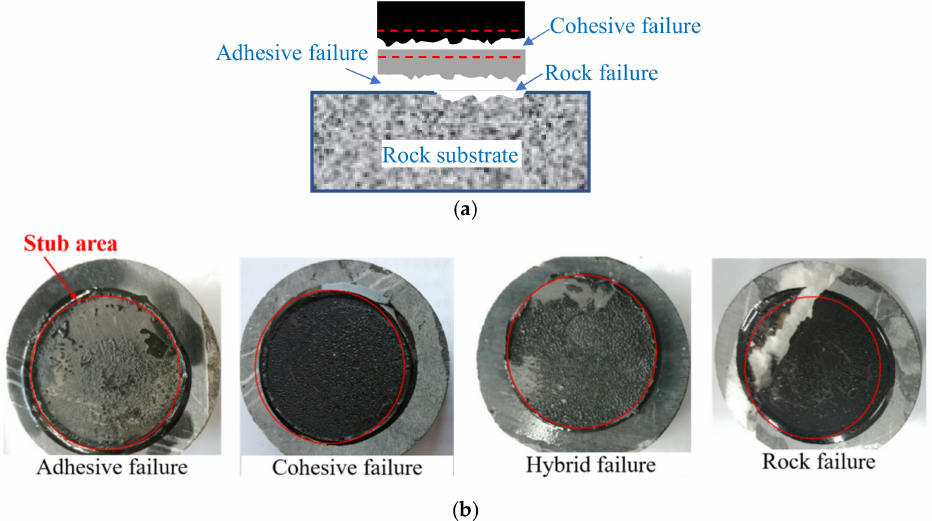
Figure 16. Various failure states of asphalt-aggregate system. ( a ) schematic diagram of various failure states; ( b ) various failures observed from